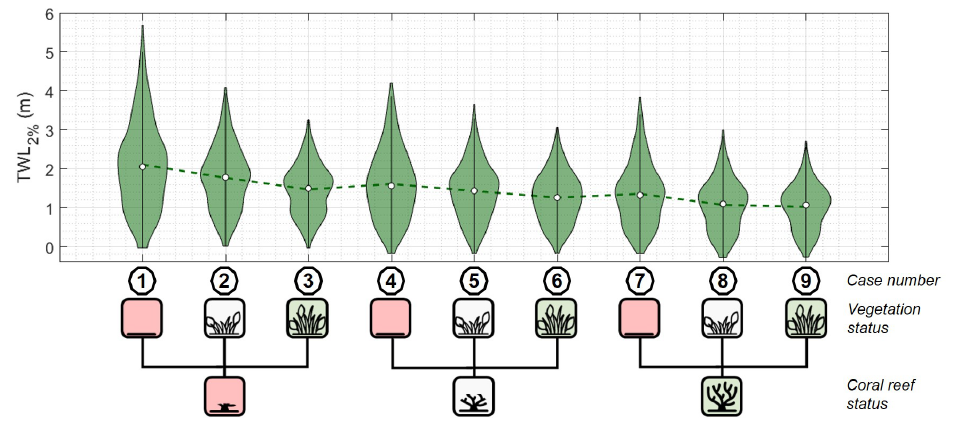
Figure 6. TWL distribution for each ecosystem configuration. The means are represented by a white point and portions between the first (0.25) and third (0.75) quartiles in the darker green color. Each ecosystem configuration is presented as pictograms to represent the status of the ecosystem (the red pictograms are for the degraded ecosystem state, the white for reference or current ecosystem state and the green for the enhanced ecosystem state).